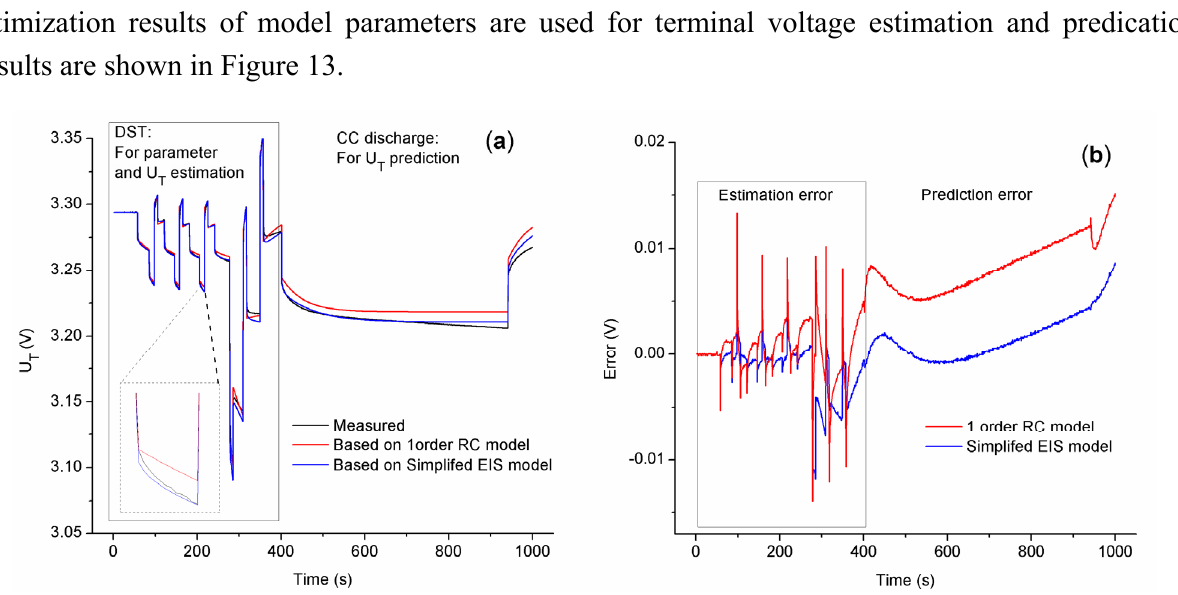
Figure 13. Comparison of battery model simulation results ( a ) simulation results and measured values of terminal voltage; ( b ) simulation